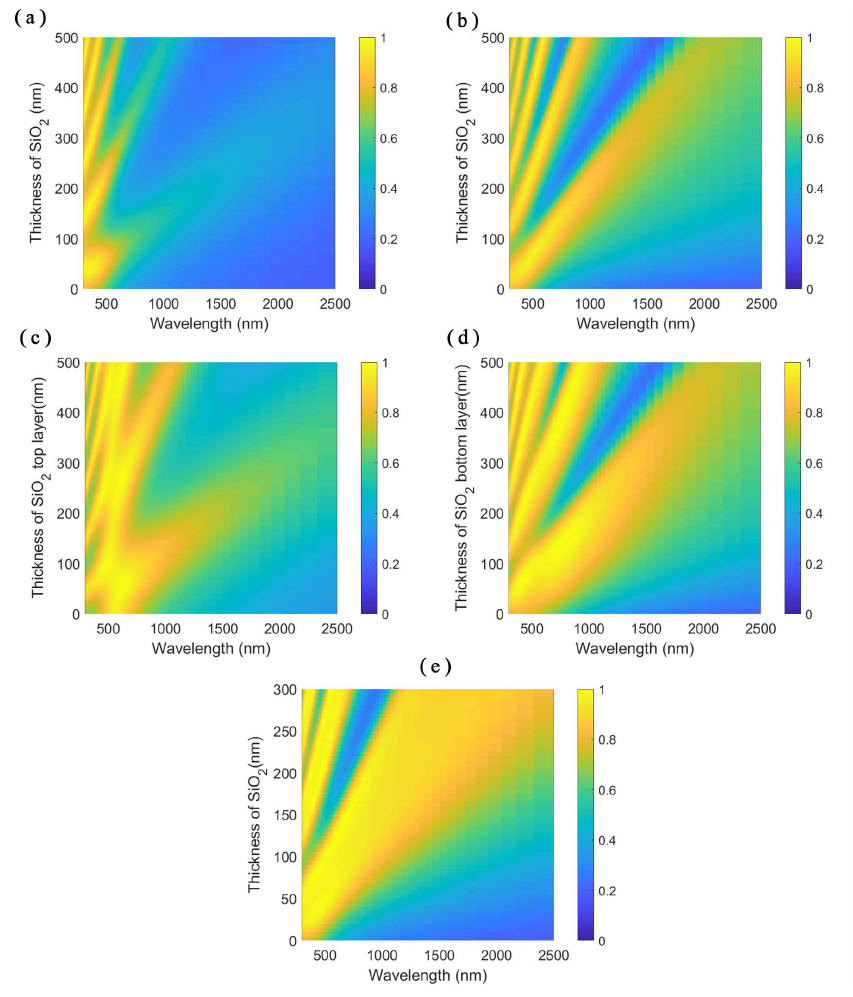
Figure 2. Absorption spectra of: ( a ) the SiO 2 /TiN stacks; and ( b ) the TiN/SiO 2 /TiN stacks with respect to the varying thickness of SiO 2 layer. Absorption spectra of the SiO 2 /TiN/SiO 2 /TiN stacks with respect to: ( c ) the varying thickness of SiO 2 layer on the top; ( d ) the varying thickness of the SiO 2 layer underneath; and ( e ) the varying thickness of both SiO 2 layers in the SiO 2 /TiN/SiO 2 /TiN four layer stacks. The thickness of the thin TiN layer is 15